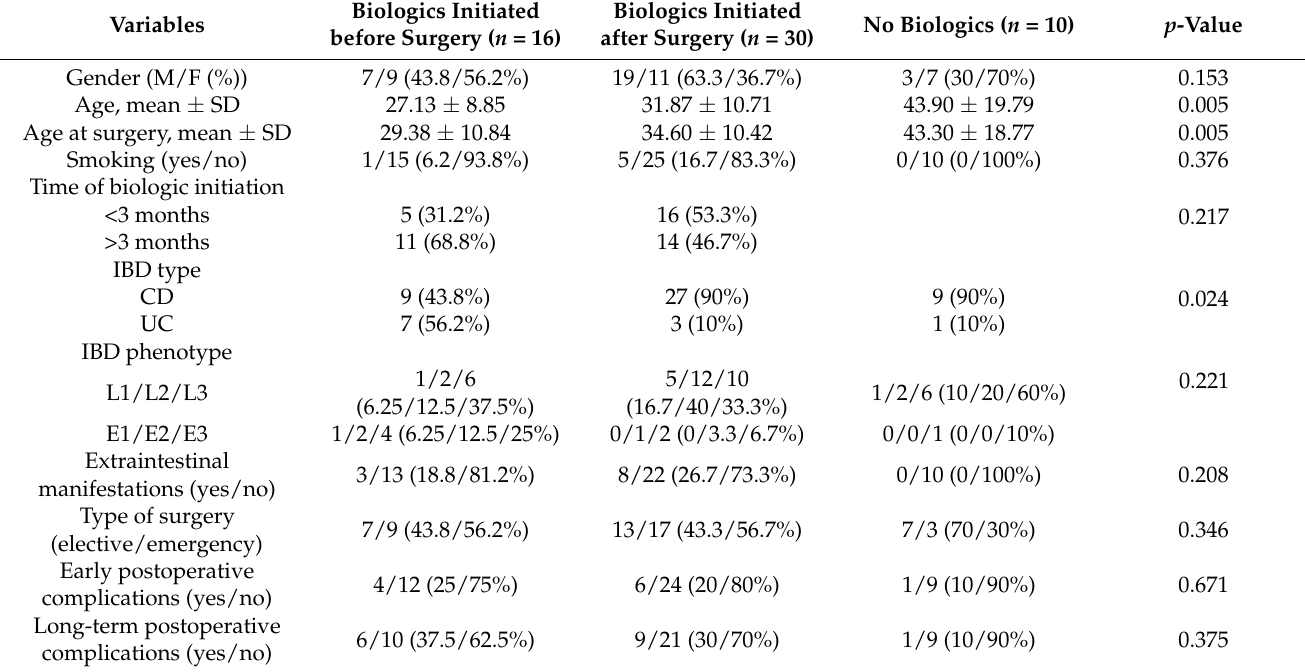
Table 1. Comparison between patients with biologics initiated before surgery vs. patients with biologics initiated after surgery vs. patients without